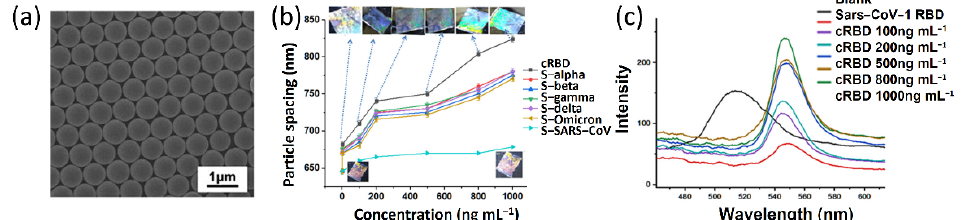
Figure 7. Responsive photonic crystals for biosensing. ( a ) SEM image of two-dimensional polystyrene array. Reprinted from [167], with permission from American Chemical Society. ( b ) Particle spacing measurements with the Debye diffraction ring diameter obtained with a laser pointer. ( c ) Measurements of the cRBD from the APC-sensor using a UV − vis spectrometer. Reprinted from [166], with permission from American Chemical Society.